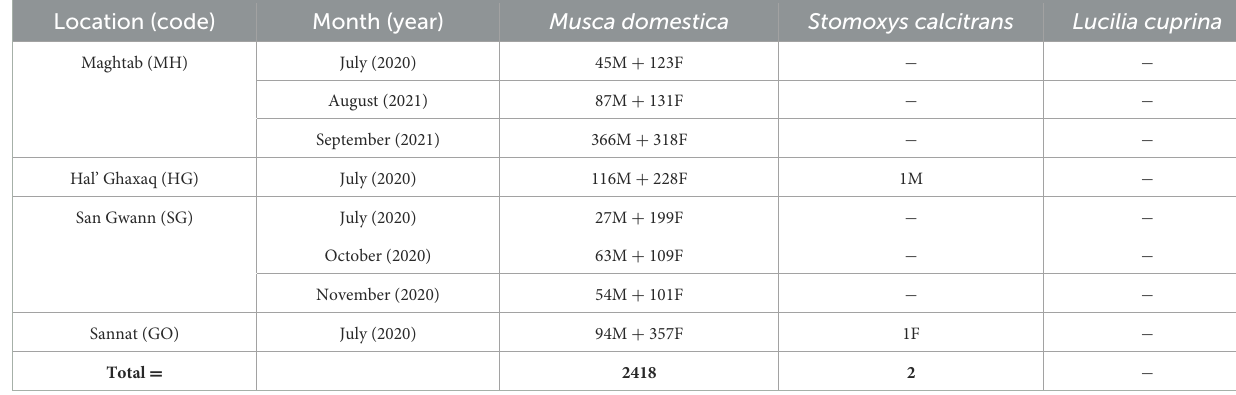
TABLE 1A Flies (M: males, F: females) collected in pens and stables at cattle farms. Location (code)